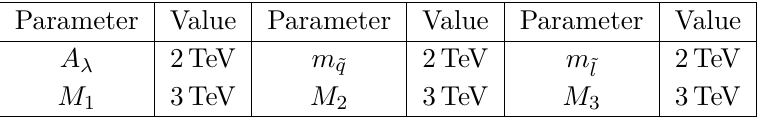
Table 1 . Setting of different fields’ soft-breaking parameters. A λ , m ˜ q , m ˜ for Higgs, squarks, sleptons, and different gaugino fields,